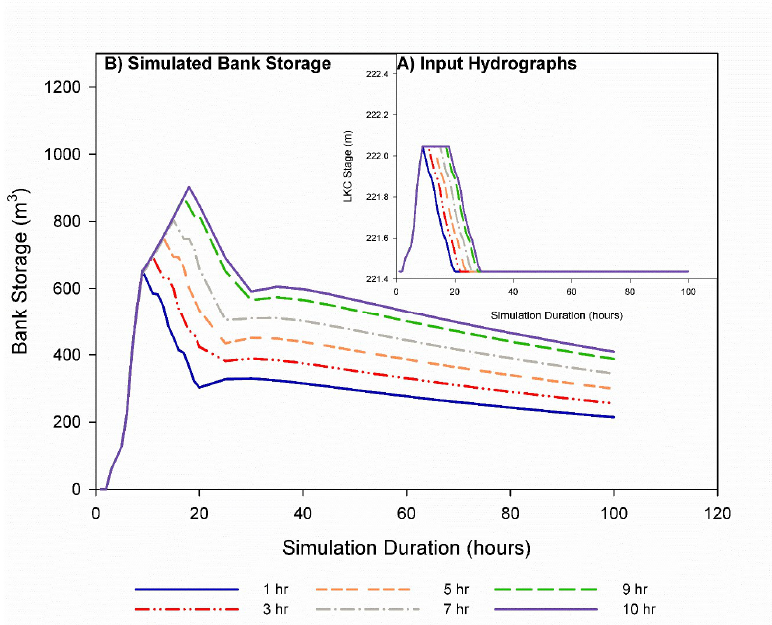
Figure 7. ( A ) Hydrograph input used in numerical model simulation for the results provided in Figure 6B. ( B ) Simulation results for model scenarios with a 0.61 m stage peaking at 9 h and held constant for various storm durations. Storage values are measured as change from beginning of simulation (first hour).